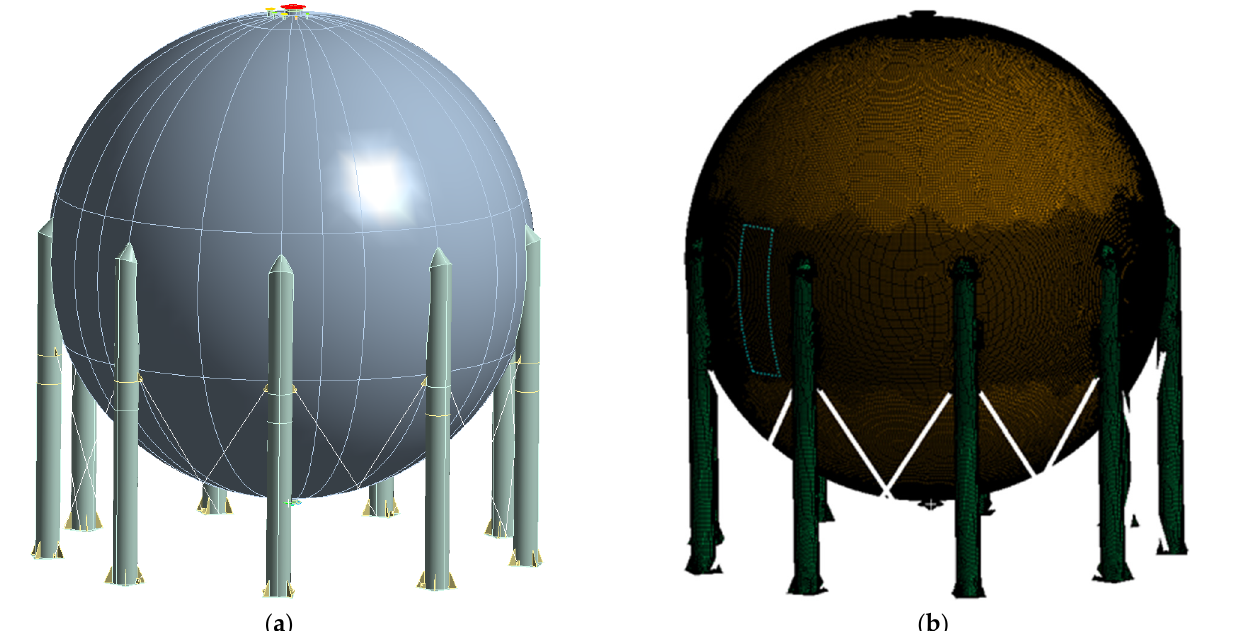
Figure 6. Shell model of the full geometry of a spherical pressure vessel ( a ), discrete model of the vessel ( b ).